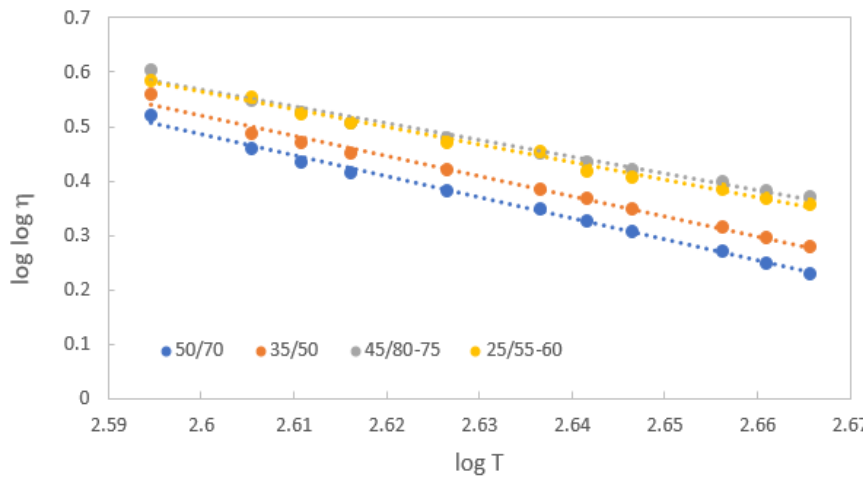
8 of 15 Figure 5. Dynamic viscosity results of tested bitumen samples 50/70 gradation, 35/50 gradation, modified bitumen samples 45/80-75 and 25/55-60. The Saal equation [8] is the most commonly used model to describe the viscosity– temperature relationship for bitumen. This model was used to fit the dynamic viscosities of bitumen samples at different temperatures. The results of fitting are shown in Figure 6 and the corresponding parameters are shown in Table 1. According to [31], the slope of a linear model of a log–log viscosity and log–temperature graph defines the viscosity–tem- perature susceptibility VTS. The VTS values of tested 50/70 and 35/50 paving grade bitu- men were determined in the range 3.71 to 4.11 and 3.64 to 3.73, respectively, and for mod-